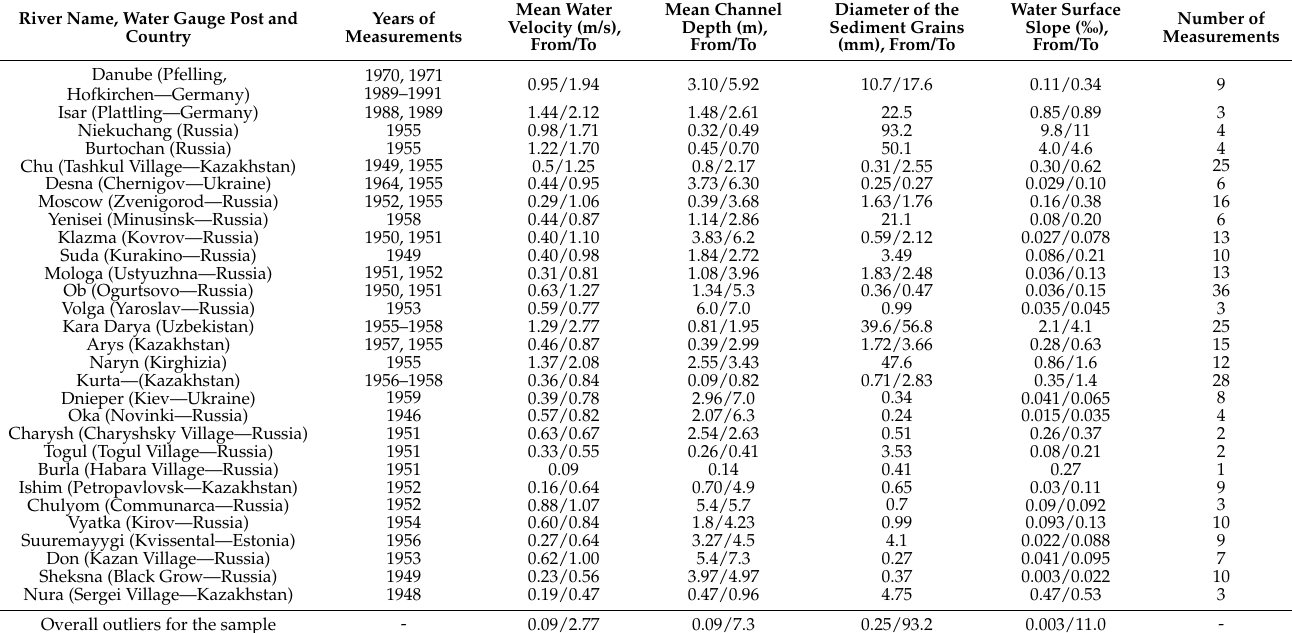
Table 1. General characteristics of the sample of measurement materials for calibration of the sediment transport model. Adapted from: Danube and Isar [17], others